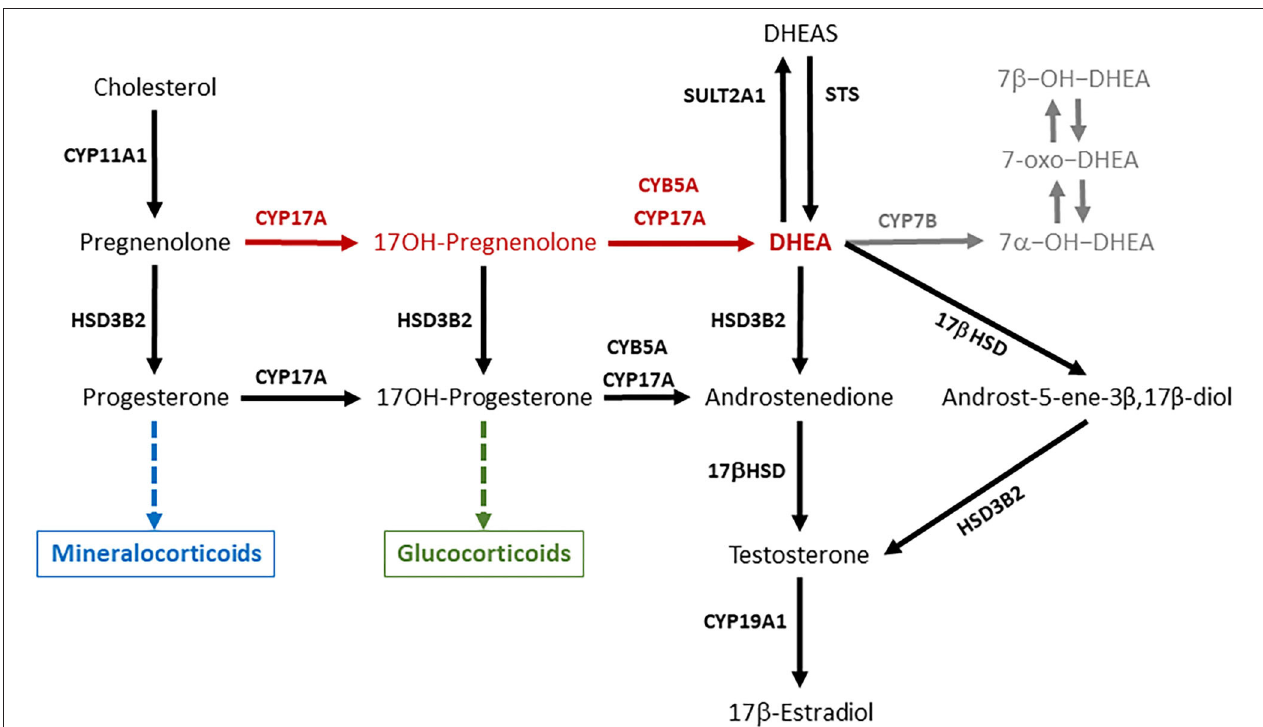
FIGURE 1 | DHEA is synthesized from pregnenolone through the 1 5 pathway (red arrows) thanks the activity of the enzyme CYP17A1. DHEA synthesis occurs in two steps, which are both mediated by CYP17A1, which compete for pregnenolone with HSD3B2, the initiator of the 1 4 pathway necessary for mineralocorticoid and glucocorticoid production. DHEA can be interconverted into DHEAS and metabolized in several extra-adrenal and extra-gonadal tissues to give rise to biologically active metabolites such as androst-5-ene-3 β ,17 β -diol and oxygenated metabolites (in gray). The ability of a steroidogenic tissue to synthesize DHEA depends on the expression and activity of CYP17A, its interaction with CYB5, and the expression of HSD3B2, which competes with CYP17A for substrates. This figure describes the general pathways involved in DHEA synthesis and metabolism, and pose some emphasis on the main enzymes involved. CYP11A1 is an inner mitochondrial membrane enzyme, also known as cytochrome P450scc (side chain cleavage), which converts cholesterol to pregnenolone. CYP17A, also known as cytochrome P450c17, is the key enzyme of the 1 5 pathway that catalyzes the conversion of pregnenolone to DHEA in two steps: (a) 17 α -hydroxylation of pregnenolone and progesterone; (b) 17,20-lyase reactions required to break the C17–C20 bond of 17-OH-pregnenolone and 17-OH-progesterone and produce C19-androgens (i.e., DHEA and androstenedione). CYB5A, also known as cytochrome b5, is an allosteric enhancer of the 17,20-lyase activity of CYP17A. HSD3B2, also known as 3 β -hydroxysteroid dehydrogenase, 1 4 / 1 5 -isomerase (3 β HSD) type 2, is the key enzyme of the 1 4 pathway, which catalyzes the oxidation of the hydroxyl group on carbon 3 of steroids to a keto group and, simultaneously, the isomerization of the double bond from the B ring ( 1 5 steroids) to the A ring ( 1 4 steroids). 17 β HSD (17 β -hydroxysteroid dehydrogenase) converts androstenedione to testosterone, and DHEA to androst-5-ene-3 β ,17 β -diol. CYP19A1, also known as cytochrome P450aro (aromatase), converts testosterone to 17 β -estraidiol and androstenedione to estrone. SULT2A1 (DHEA sulfotransferase) converts DHEA in DHEAS. STS (steroid sulfatase) is the primary enzyme involved in steroid desulfation. CYP7B is the main responsible for the generation of 7 α -hydroxylated steroids in diverse extra-hepatic